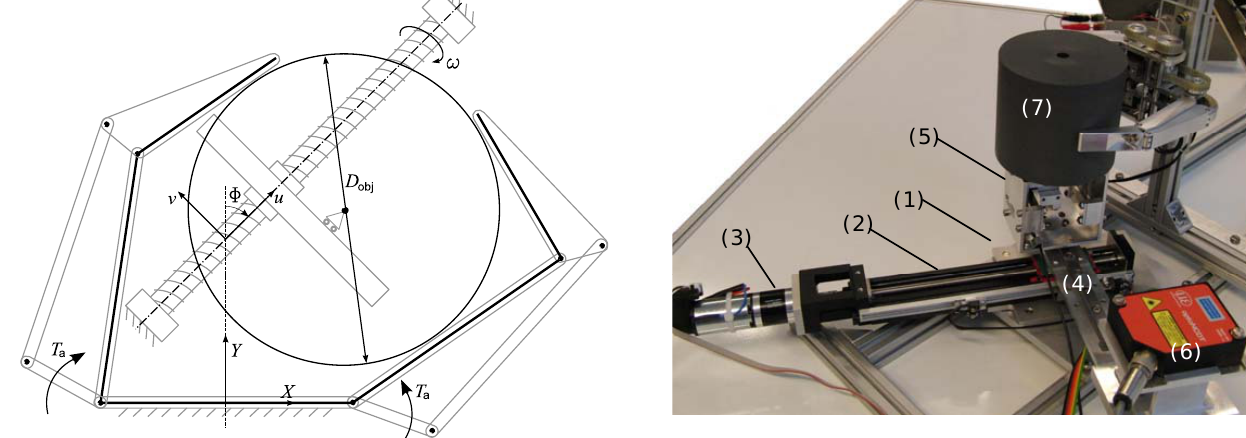
Figure 3. Photo of the setup for benchmark test 2 where (1) is a turning table, (2) is a ball screw spindle, (3) is the motor to drive the spindle; (4) is a linear guide perpendicular to the spindle; (5) is the force sensor supported by a construction of leaf springs; (6) is an optical displacement sensor; and (7) is a cylindrical